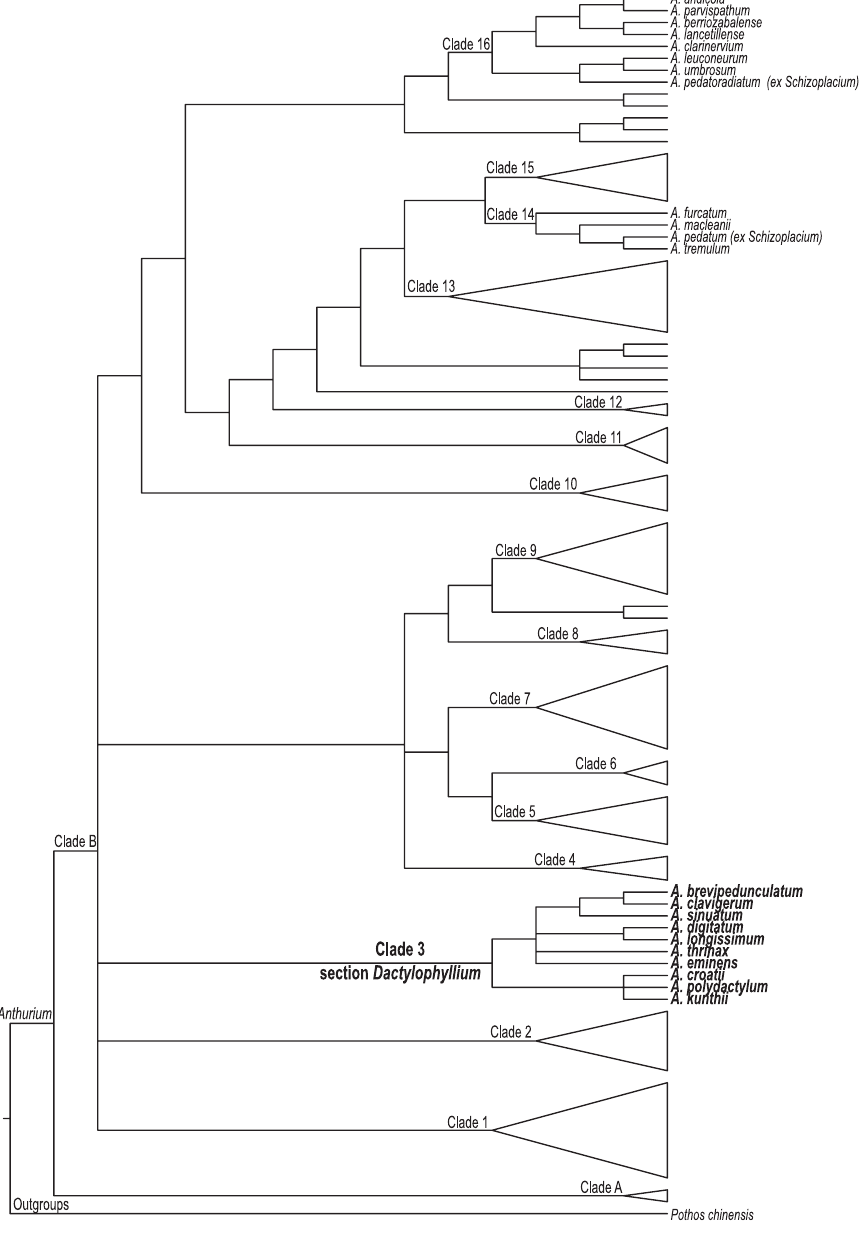
Figure 3. A schematic molecular phylogeny of Anthurium showing major clades recovered by Carlsen and Croat (in press). This phylogeny was based on combined chloroplast ( trnG intron, trnH–psbA and trnC–ycf6 intergenic spacers) and nuclear (first intron of CHS and partial flanking coding regions) DNA sequences. Clade numbering follow these authors. Species in bold are recognized here as members of Anthurium section Dactylophyllium (Schott) Engler, emend. Croat & Carlsen. Placement of Anthurium species now excluded from grex Schizoplacium Schott is also